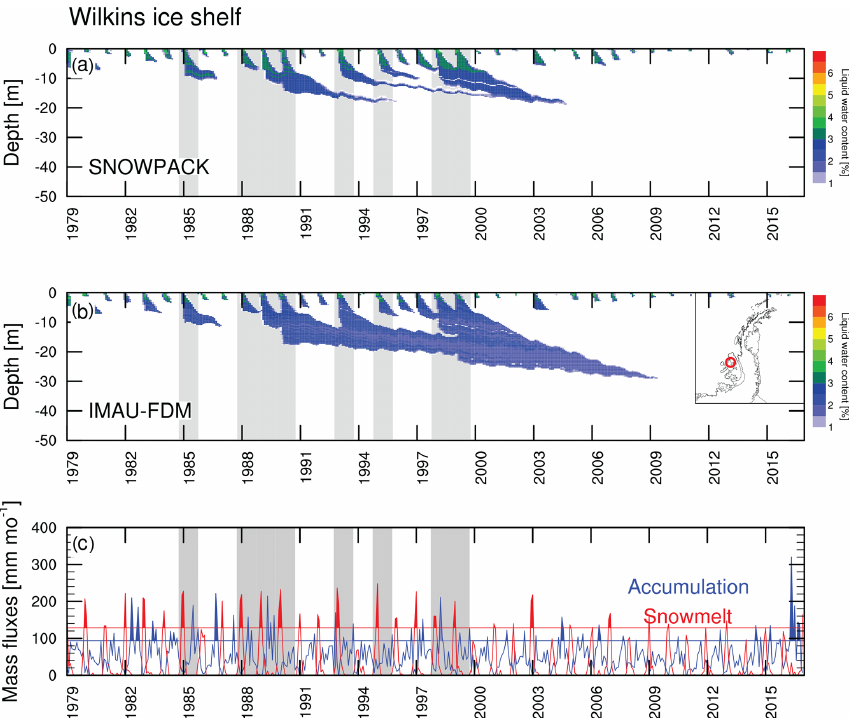
Figure 10. Volumetric water content for SNOWPACK (a) and IMAU-FDM (b) for 1979–2016 at a location on Wilkins Ice Shelf (see inset and Fig. 5). (c) Monthly accumulation (blue) and surface meltwater production (red) for the same location; horizontal lines denote the mean + 1-standard-deviation ( σ ) threshold. Grey bars denote hydrological years in which > 5% of meltwater is retained. Only RACMO2 surface meltwater production is shown for clarity, which is similar to SNOWPACK values (see Fig.